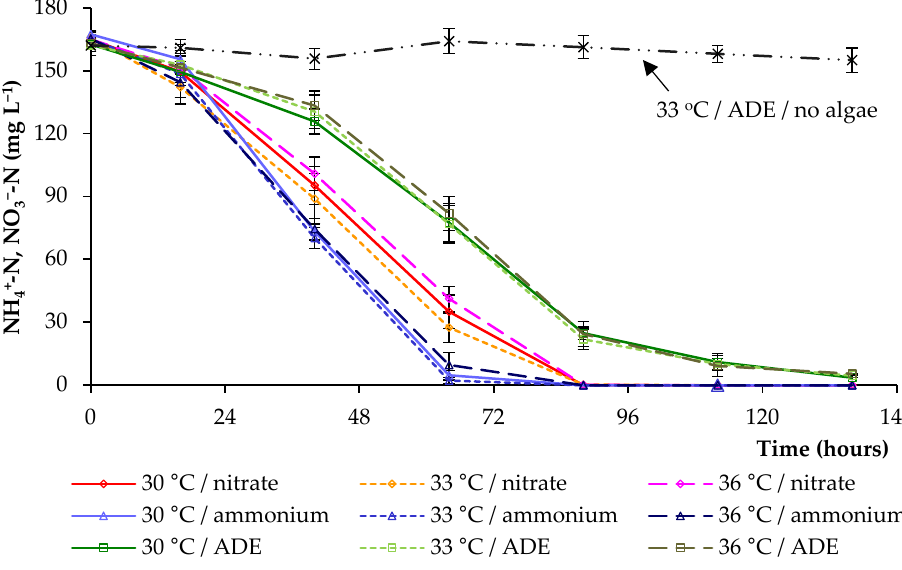
Figure 4. Nitrogen removal by C. sorokiniana AM-02.